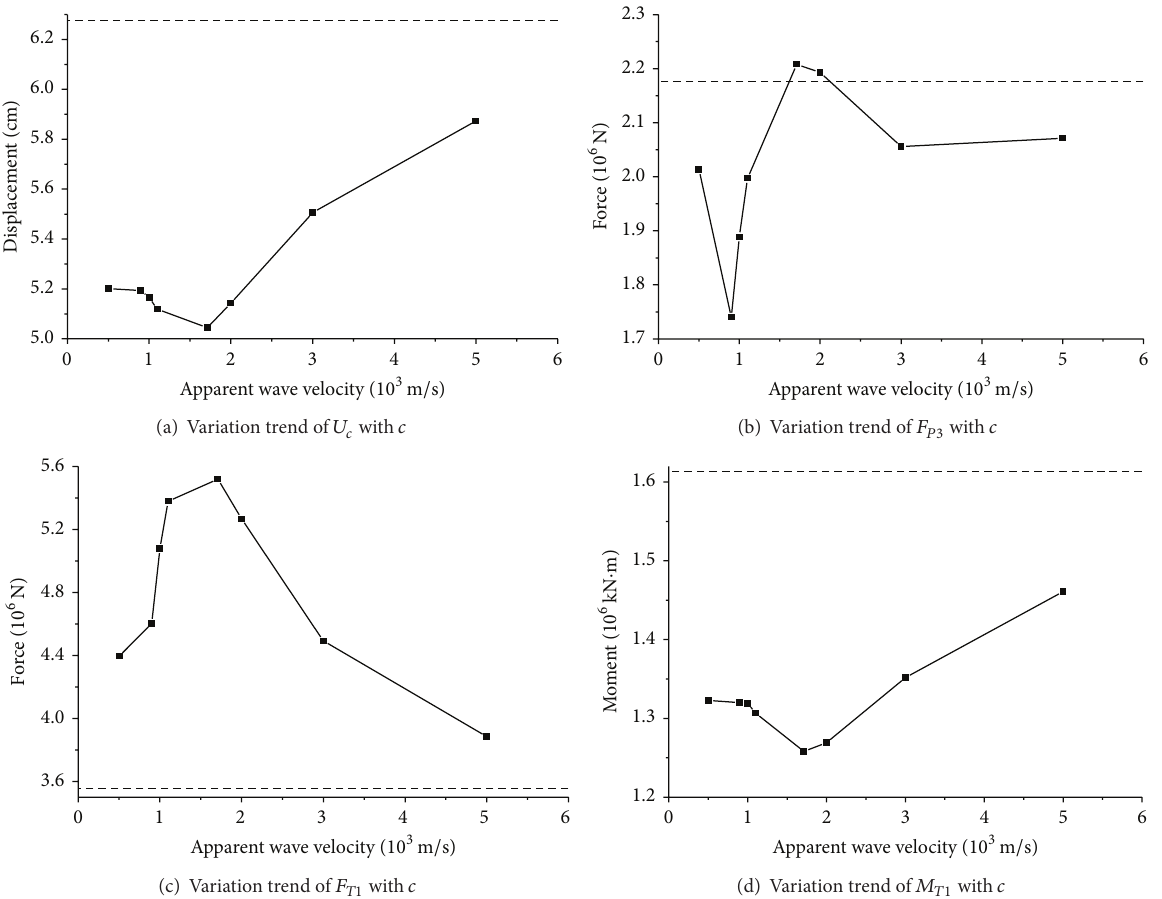
Figure 13: Variation trend of peak structural seismic responses with apparent wave velocity under the excitation of 𝑏 1